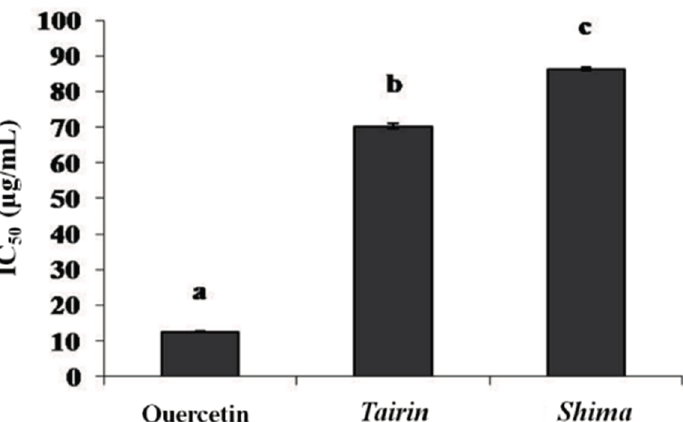
Figure 3. Inhibition of xanthine oxidase activity by tairin and shima essential oils (EOs). Values shown represent the mean ± standard error from three independent experiments.